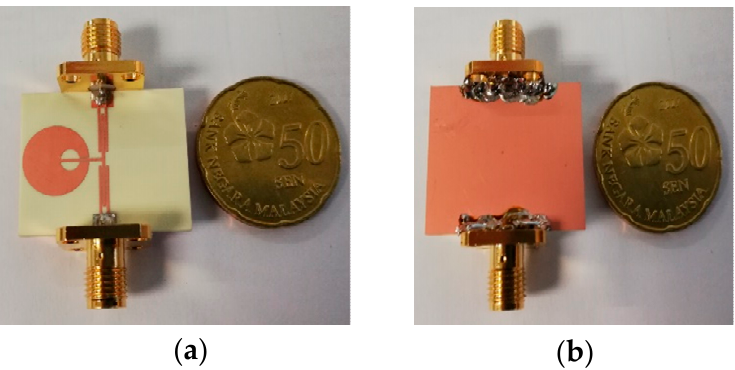
Figure 8. Prototype of the UWB single-wing bandpass filter: ( a ) Front view, ( b ) Back view. The multimode bandpass filter is measured using Vector Network Analyzer (VNA).